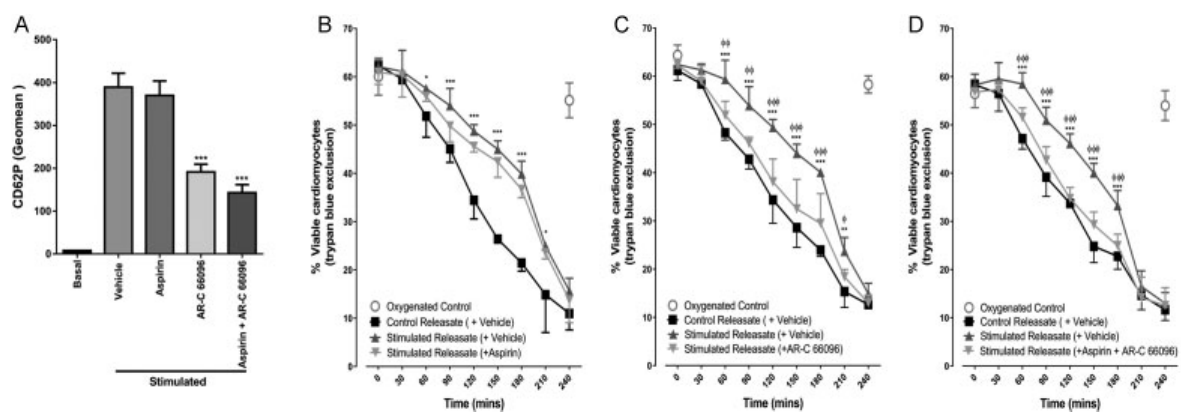
Fig. 4 Targeting platelet P2Y 12 , but not cyclooxygenase, reduces platelet secretion and cardioprotection. ( A ) Washed platelets (2 (cid:1) 10 8 /mL) from WT mice were pretreated with vehicle (Tyrode ’ s) or inhibitors; 30 µM aspirin (cyclooxygenase) and 1 µM AR-C 66096 (P2Y 12 antagonist) for 10 minutes, then stimulated with 10 µg/mL CRP and analyzed for α -granule secretion by surface CD62P exposure. Data are mean (cid:4) SD; n ¼ 4, (cid:5)(cid:5)(cid:5) p < 0.001, one-way ANOVA with Bonferroni post hoc test. ( B – D ) Cardiomyocytes preconditioned with releasates from vehicle-treated (control) or CRP-treated (stimulated) WT platelets in the absence ( þ Tyrode ’ s vehicle) or presence of ( B ) 30 µM aspirin, ( C ) 1 µM AR-C 66096, and ( D ) 30 µM aspirin þ 1 µM AR-C 66096 were monitored for changes in viability during ischemic injury, with nonischemic (oxygenated control) samples monitored at 0 and 240 minutes time points. Data are mean (cid:4) SD; n ¼ 4, (cid:5) p < 0.05, (cid:5)(cid:5) p < 0.01, (cid:5)(cid:5)(cid:5) p < 0.001 versus WT-controlled releasate ( þ vehicle ( B – D )) and Φ p < 0.05, ΦΦ p < 0.01, ΦΦΦ p < 0.001 versus stimulated releasate ( þ Aspirin ( B )/ þ ARC66096 ( C )/ þ Aspirin þ AR-C66096 ( D )), two-way ANOVA with Bonferroni post hoc